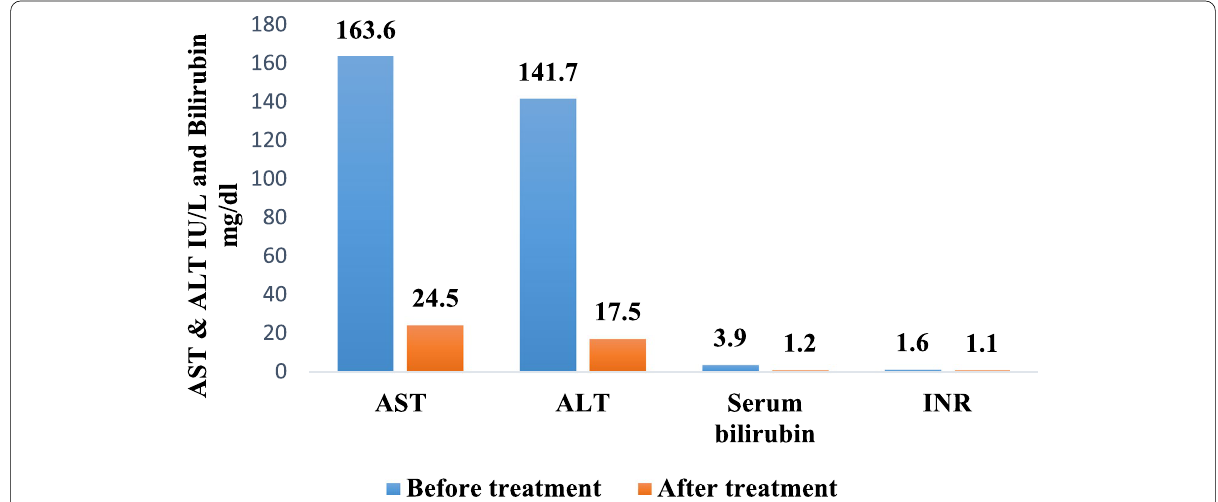
Fig. 8 Median LFT in hepatic presentation before and after treatment (survived, n